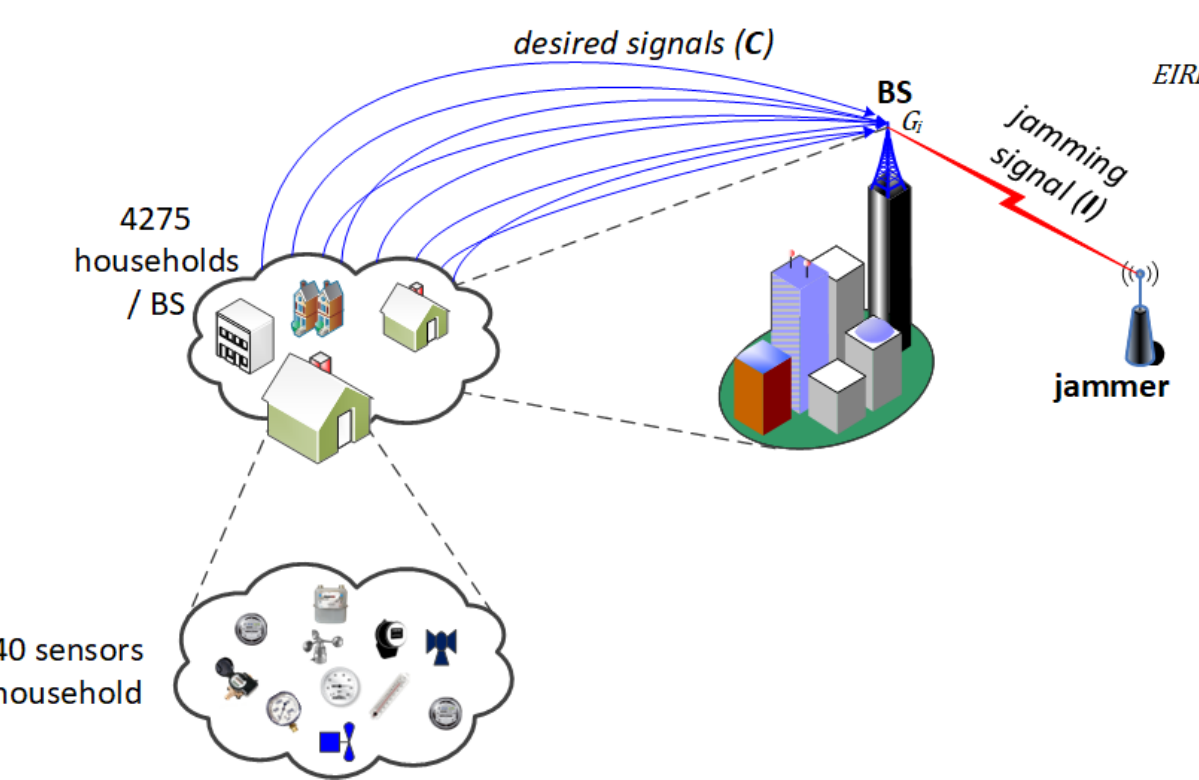
Figure 1. An Internet of Things (IoT) network exposed to intentional jamming.